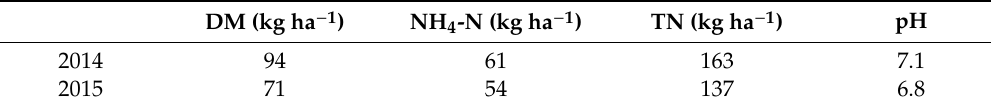
Table 1. Characteristics of slurry manure used in this study. Dry-matter (DM), total NH 4 -N, total N (TN), and pH in two years of the experiment.